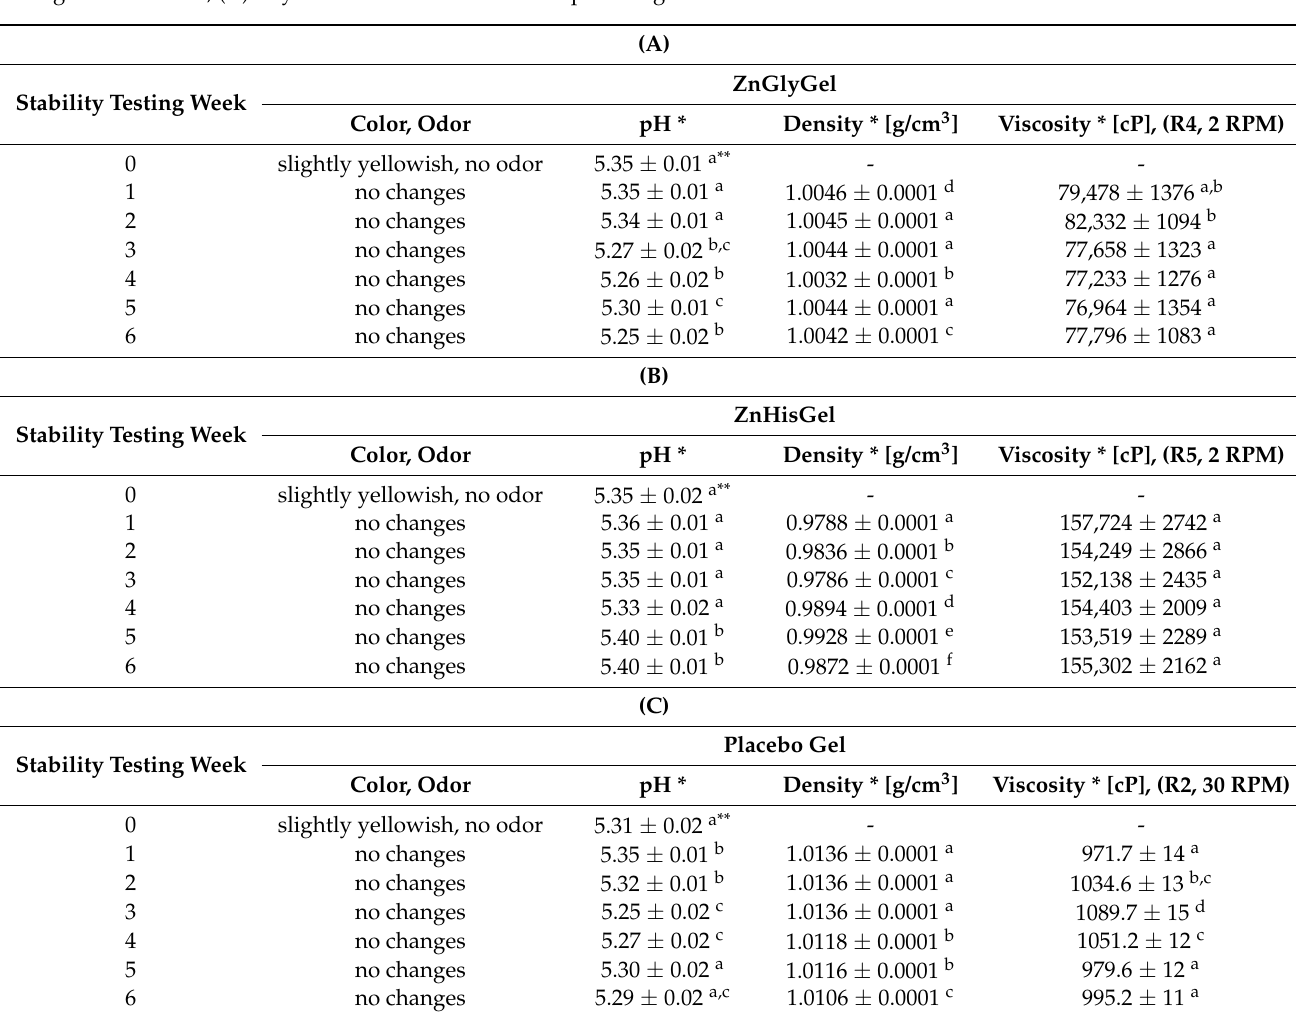
Table 3. ( A ) Physicochemical evaluations of Zn-Glycine gel formulation; ( B ) Physicochemical evaluations of Zn-Histidine gel formulation; ( C ) Physicochemical evaluations of placebo gel